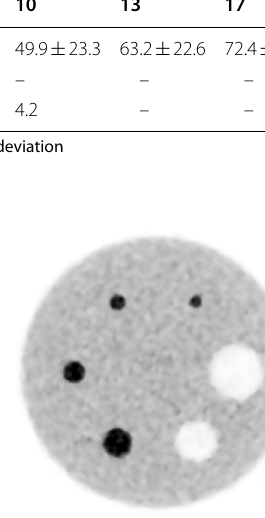
Fig. 5 PET image of the brain‑size image‑quality phantom used to measure percent contrast and percent background variability